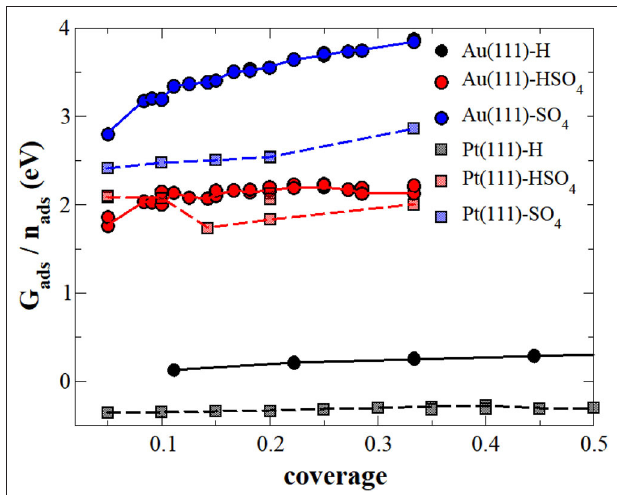
FIGURE 1 | Adsorption energy ( G ads ) of sulfate (blue), bisulfate (red) or hydrogen (black) per molecule or atom, respectively, on Au(111) (continuous lines) and Pt(111) (dashed lines) surfaces under vacuum conditions. The lines serve as a visual